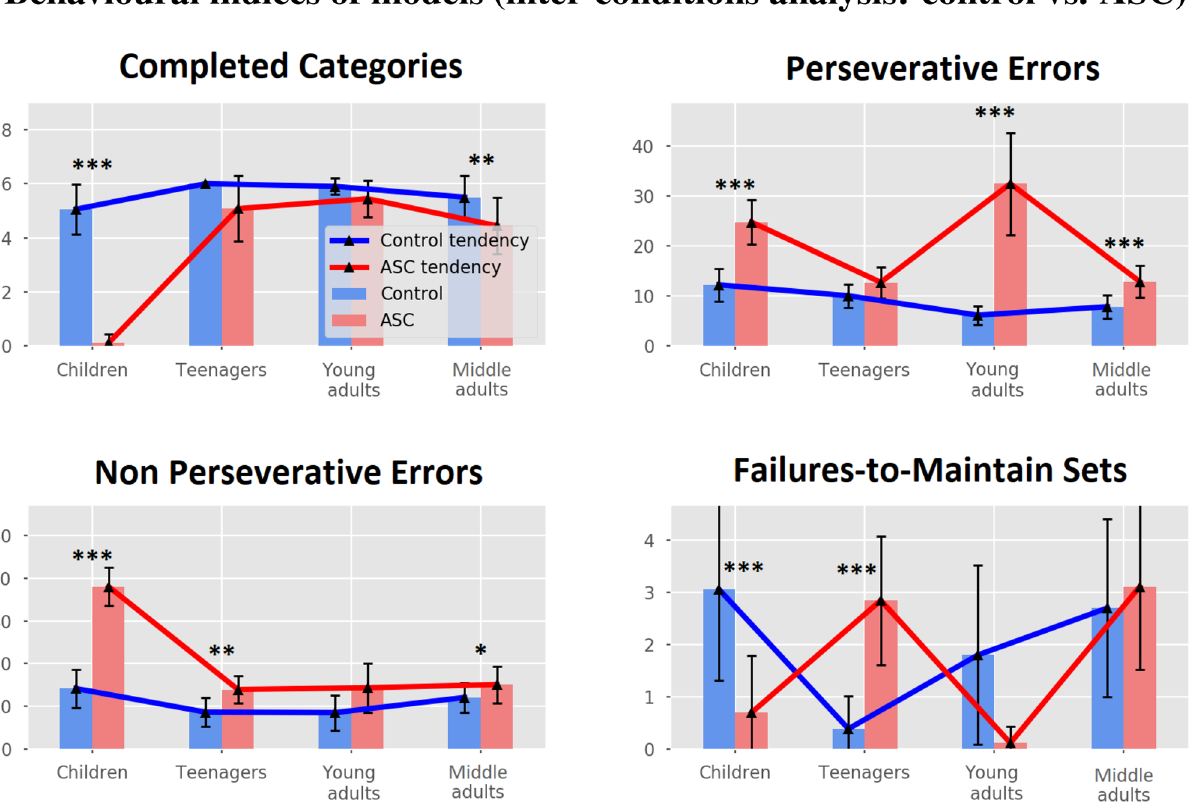
Figure 4. Behavioural indices and comparisons of all models (Children, Teenagers, Young adults, Middle